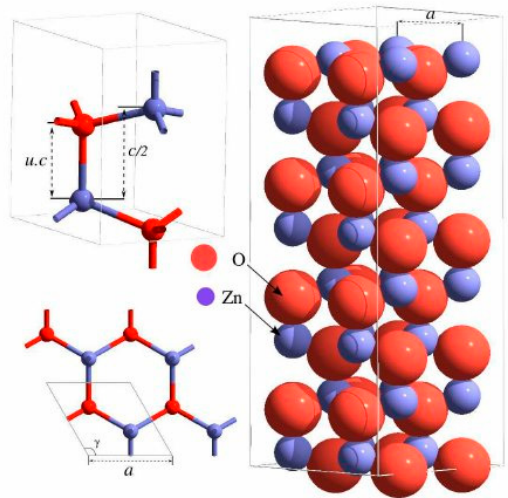
Figure 10. Bulk crystal structure of wurtzite Zinc oxide [203]. Reprinted Figure with permission from Simulation of reconstructions of the polar ZnO (0001) surfaces, as follows: H. Meskine and P. A. Mulheran, Phys. Rev. B 84, 165430, 2011. Copyright 2021 by the American Physical Society.